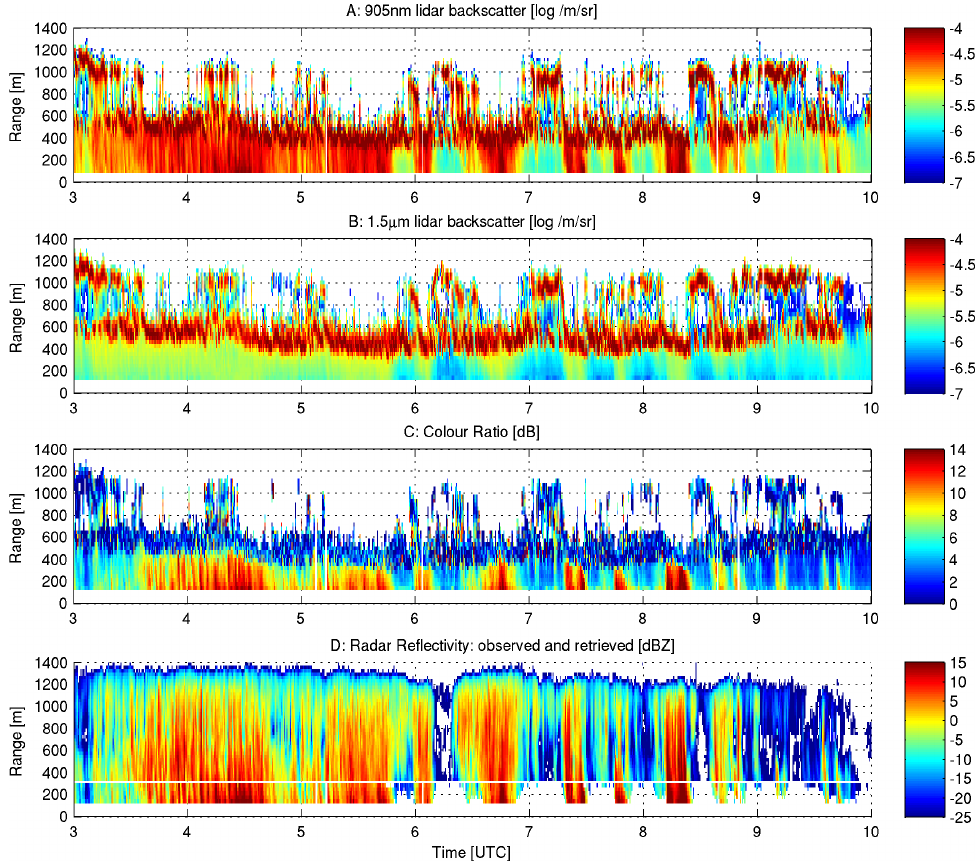
Fig. 9. Lidar and radar observations, case II: 14 December 2006. Panel (A) shows lidar backscatter at 905nm, panel (B) same at 1.5µm. Panel (C) is the lidar colour ratio. Panel (D) shows the measured radar reflectivity (data points above 350m) and the lidar-retrieved reflectivity (data below 350m).